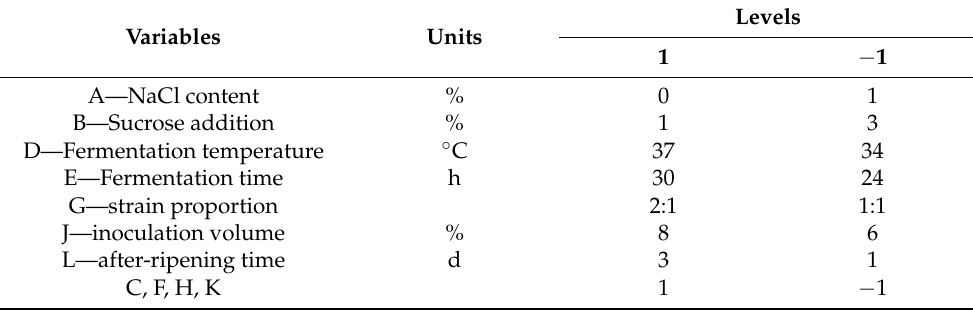
Table 1. Minimum and maximum range of the parameters selected in the PB design.